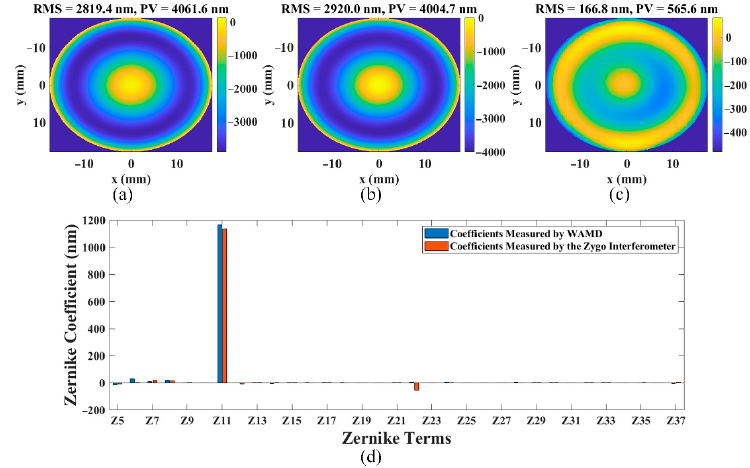
Figure 8. Wavefront aberration of the plano-convex lens in the experiment: ( a ) measured by WAMD; ( b ) measured by a Zygo interferometer; ( c ) difference between ( a , b ); ( d ) comparison of Zernike co- efficients.